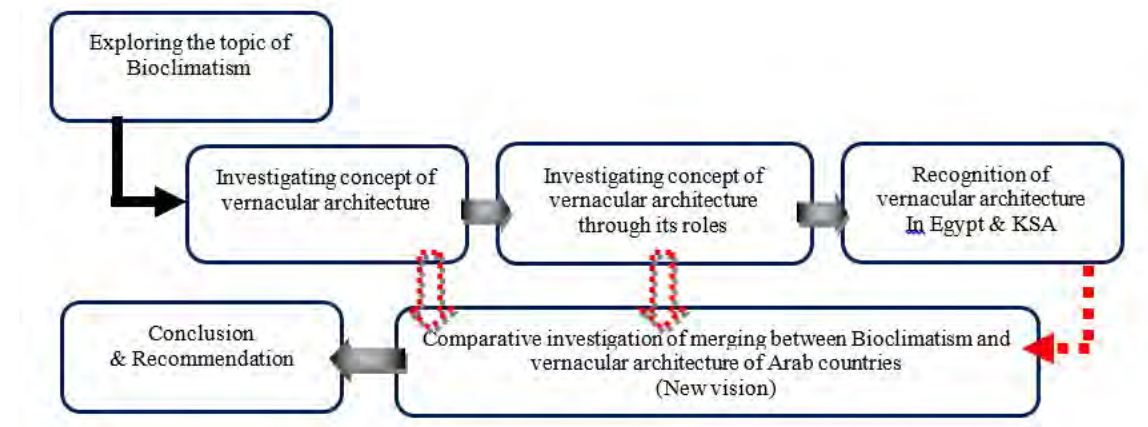
Figure 1. Process of research and analysis by